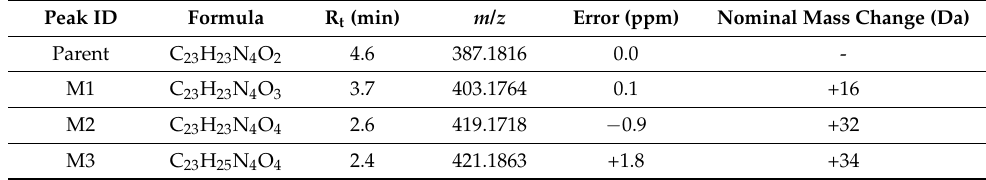
Table 1. Characterization of In vitro metabolites of fiscalin B ( 1 ) by